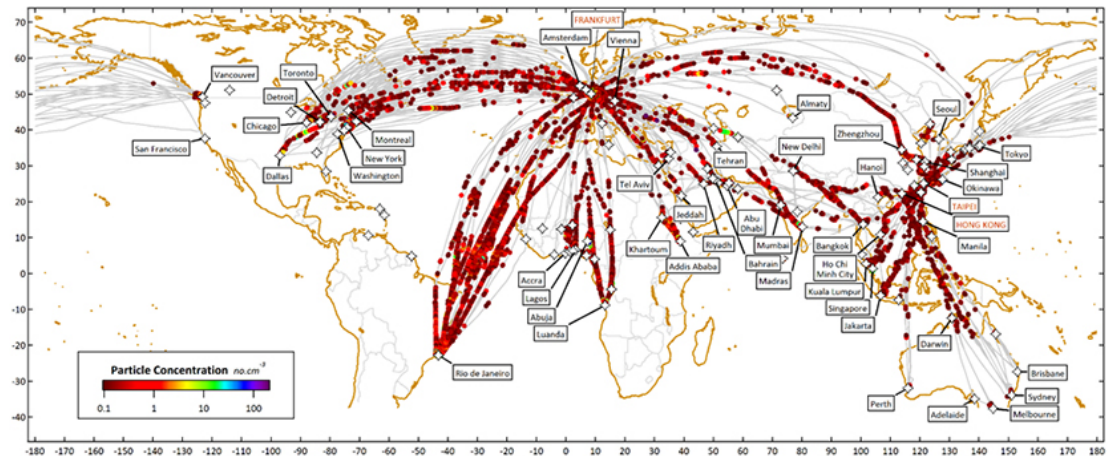
Figure 13. The trajectories for the Lufthansa (September, 2011–March, 2013) and China Airlines (January–March, 2013) commercial flights are shown here encoded with cloud encounters (colored, filled circles) and locations of arrivals and departures (yellow diamonds). The color scale shows the number concentrations of the clouds that were